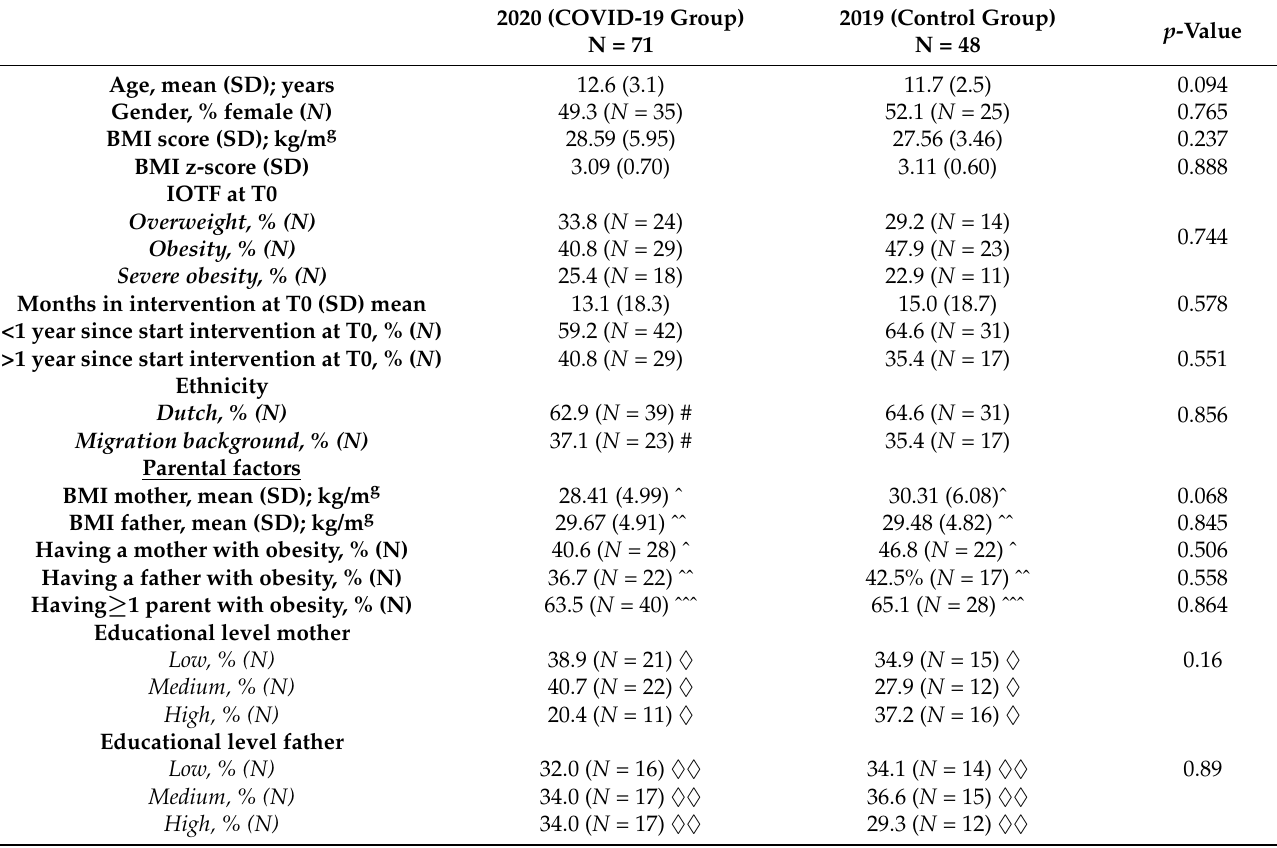
Table 1. Baseline